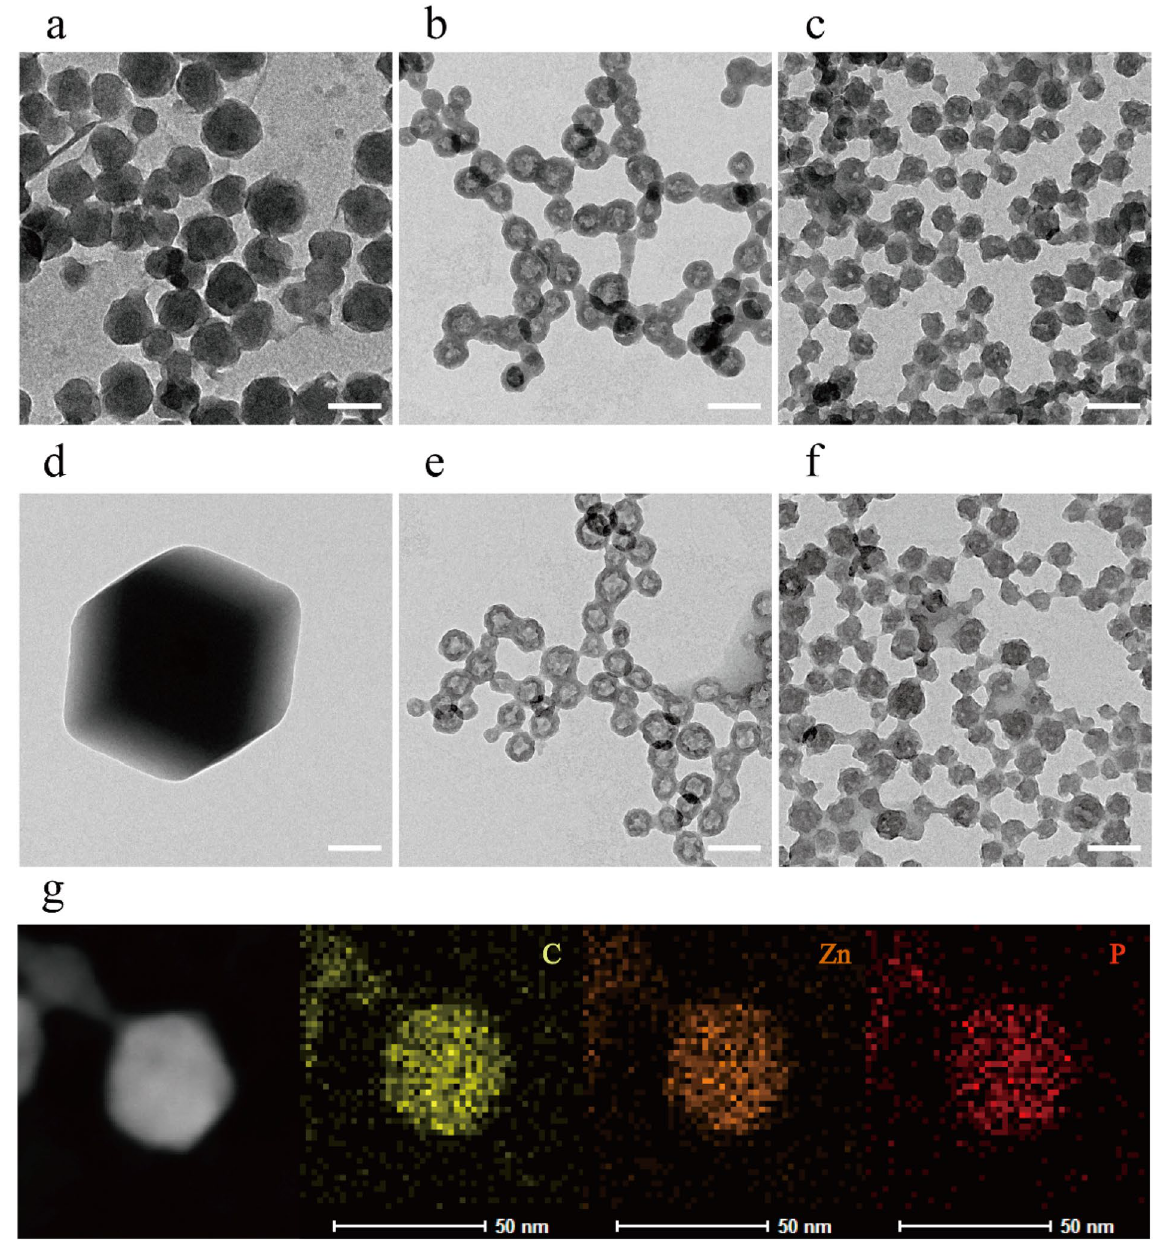
Figure 2. TEM images of ZIF-8, ZZF, and ZZF@PVP nanoparticles when synthesized ( a – c ) and after storage in water for 2 weeks ( d – f ), respectively. Scale bar = 100 nm. TEM and the element mapping image of the distribution of carbon, zinc, and phosphorus in individual ZZF@PVP nanoparticles ( g ). Scale bar = 50